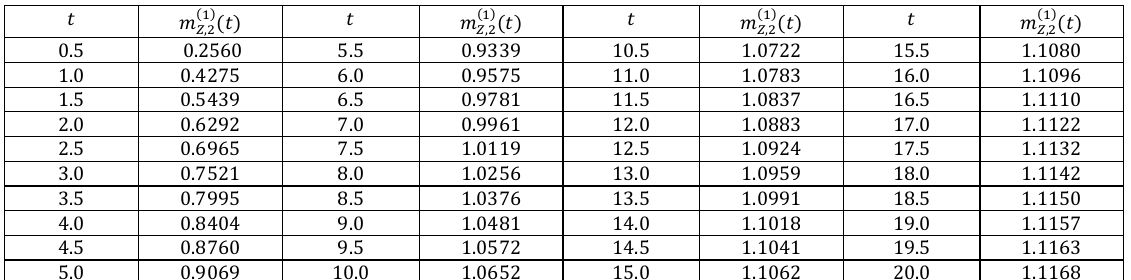
Table 2. Environment level 2 dependent growth of maligant cells (One mutation